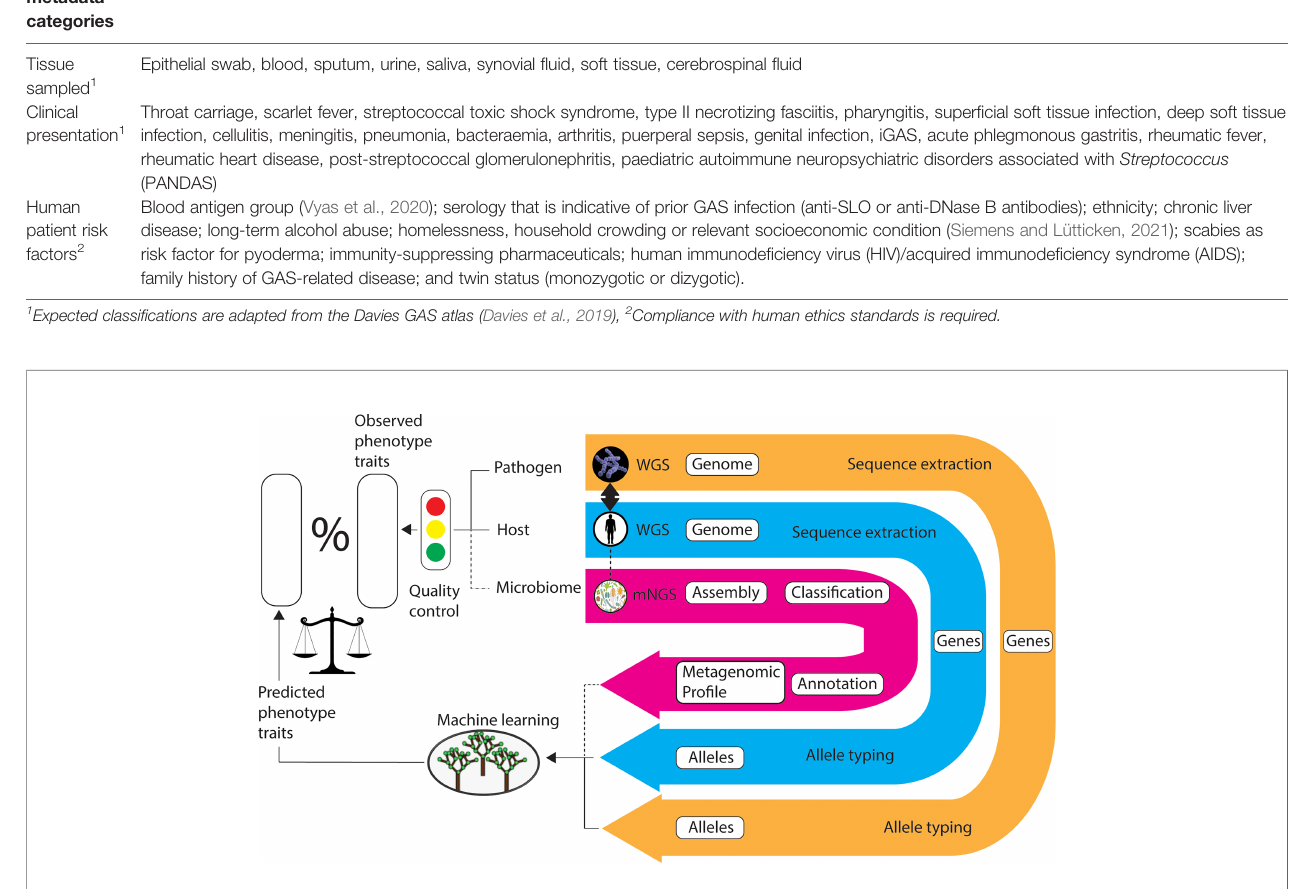
FIGURE 1 | Work fl ow for the application of machine learning in comparative genomics genotype-phenotype association studies. ‘ Linked ’ samples of microbe, host, and microbiome (optional) are simultaneously collected and sequenced. Recommended virulence phenotype metadata is also collated and assessed for quality. The DNA sequences of target genes (for example, transcription regulators) are extracted and the alleles are typed. Machine learning algorithms are applied to the allele types (predictor variables) in the prediction of response variables (for example, invasive virulence phenotype). The machine learning models are validated by comparison of observed and predicted phenotype data. The most important predictor variables are selected as the basis of dimension reduction, as required. Legend: WGS, whole-genome sequencing; mNGS, metagenomic next generation